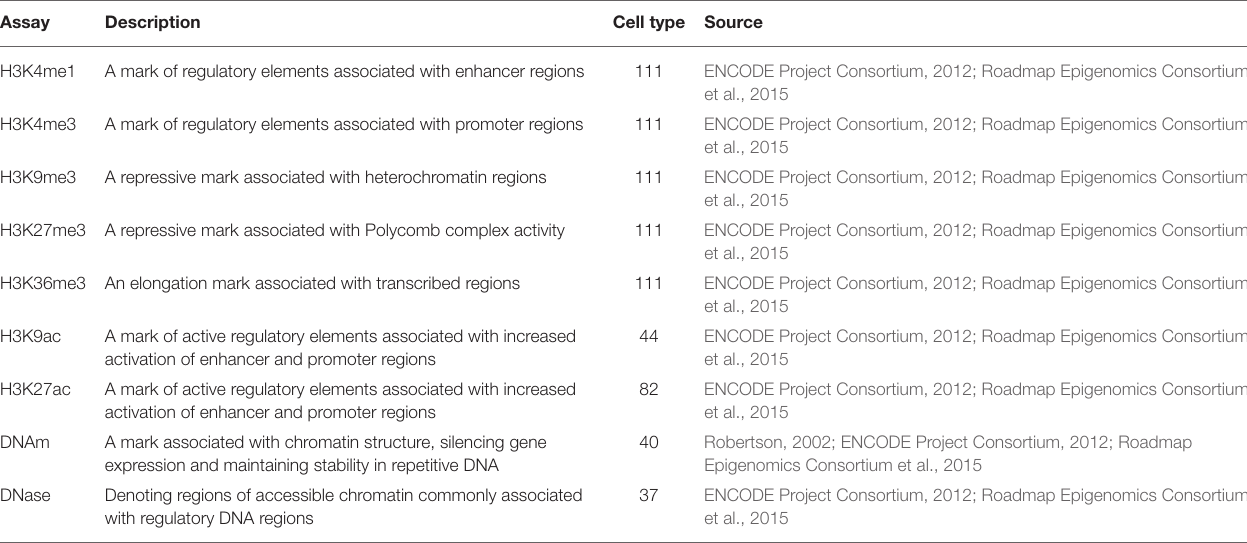
TABLE 2 | Epigenetic marks analyzed in this